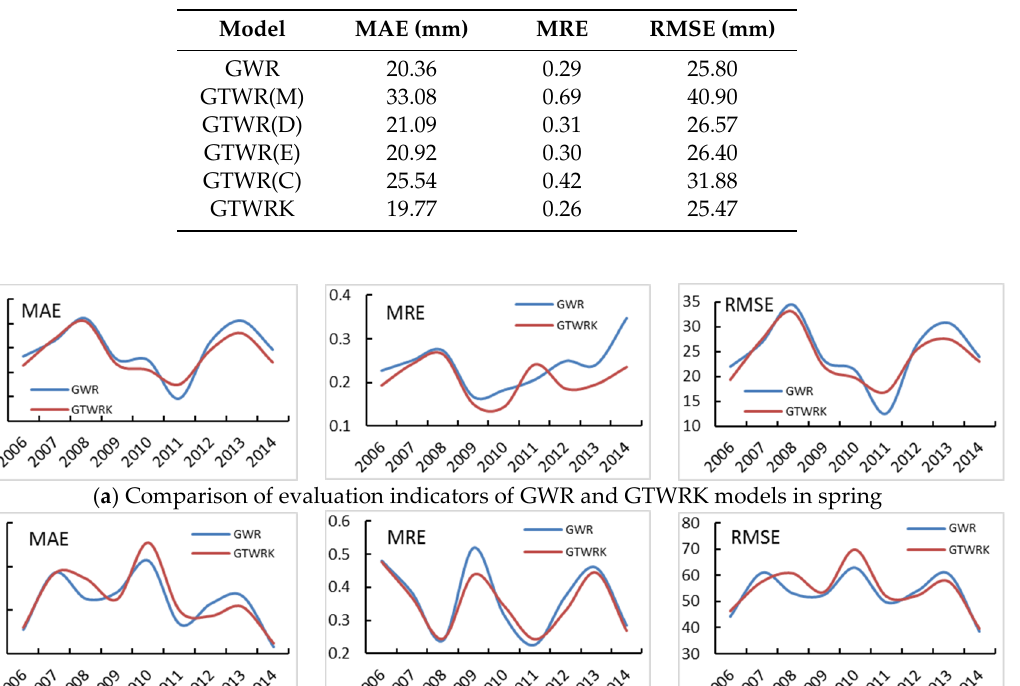
Table 2. The average MAE, MRE, and RMSE for the monthly scale data.